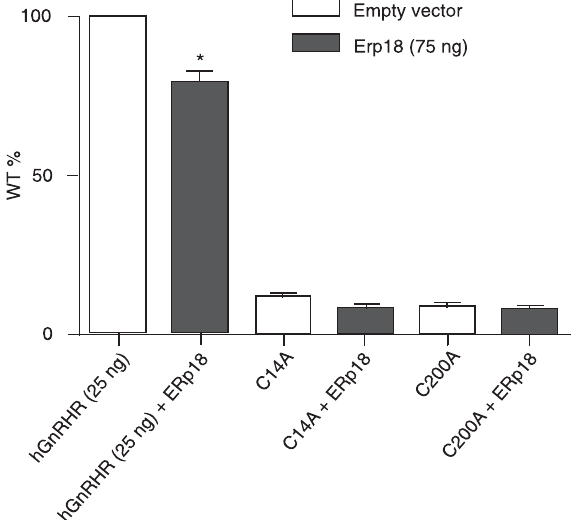
Figure 2. Wild type percent (WT%) indicates the inositol phos- phate production upon buserelin stimulation of WT human go- nadotropin-releasing hormone receptor (hGnRHR) and mutant GnRHRs (C14A and C200A) co-transfected with the ERp18 chaperone. Data are reported as mean ± SEM of at least three independent experiments in triplicate incubations. *P <